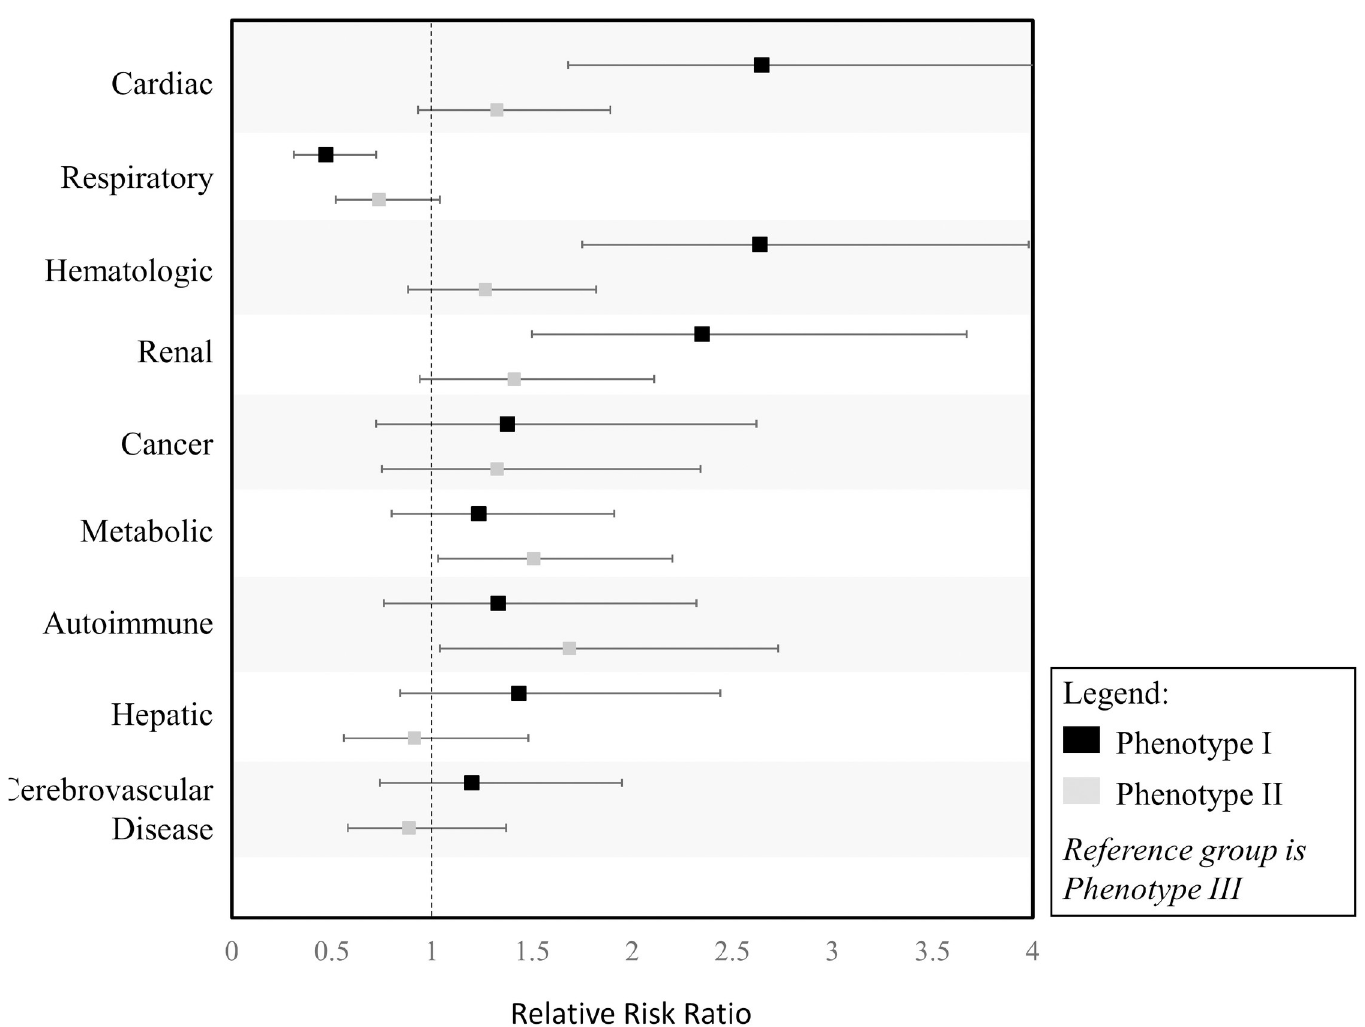
Fig 3. Relative risk ratio of comorbidities to clinical phenotypes. Relative Risk ratios of comorbidities of phenotypes I and II compared to the reference group phenotype III.